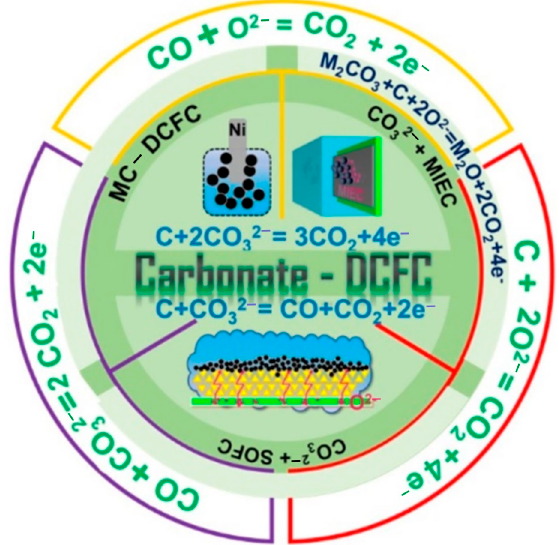
Figure 15. Schematic of a DCFC in the presence of carbonate, including cell systems CO 3 2 − + SOFC, CO 32 − + MIEC and MC-DCFC, and some possible reactions (reproduced from Ref. [179]; copyright © 2021 The Authors, this is an open access article distributed under the terms of the Creative Commons CC BY license, which permits unrestricted use, distribution, and reproduction in any medium, provided the original work is properly cited).